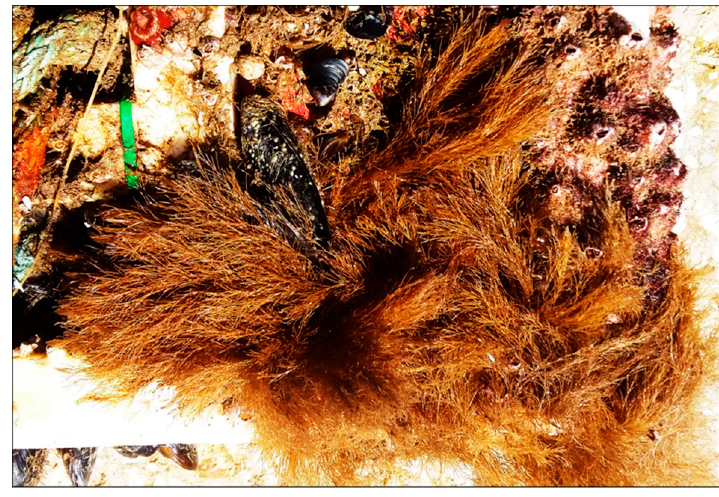
Figure 3. Bryozoans (cf. Bugula sp .) growing on test panels.